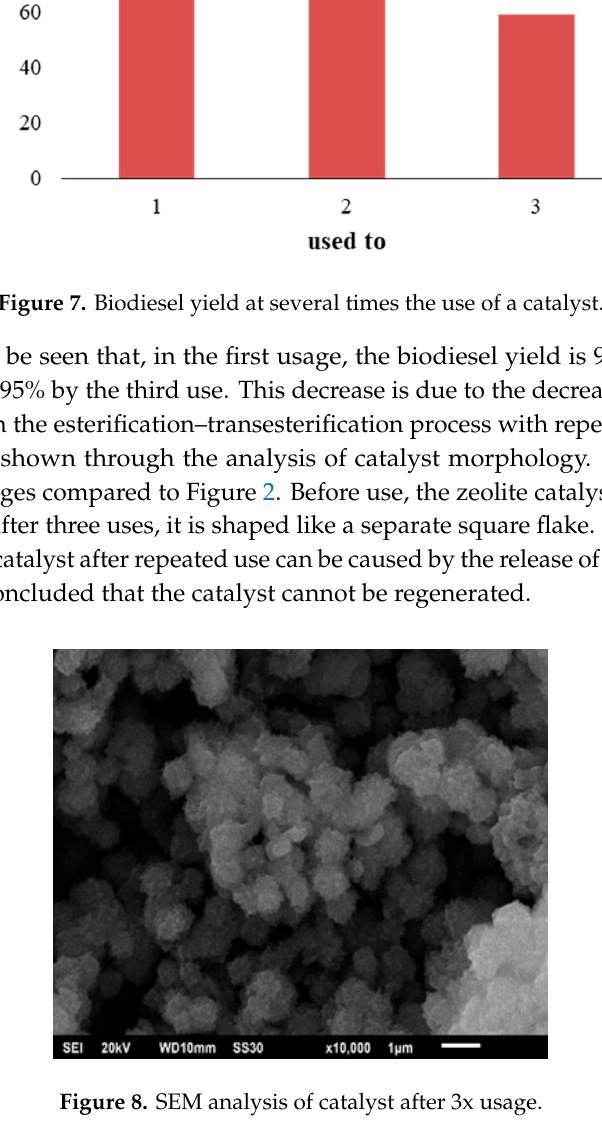
Figure 6. Effect of temperature on biodiesel yield.